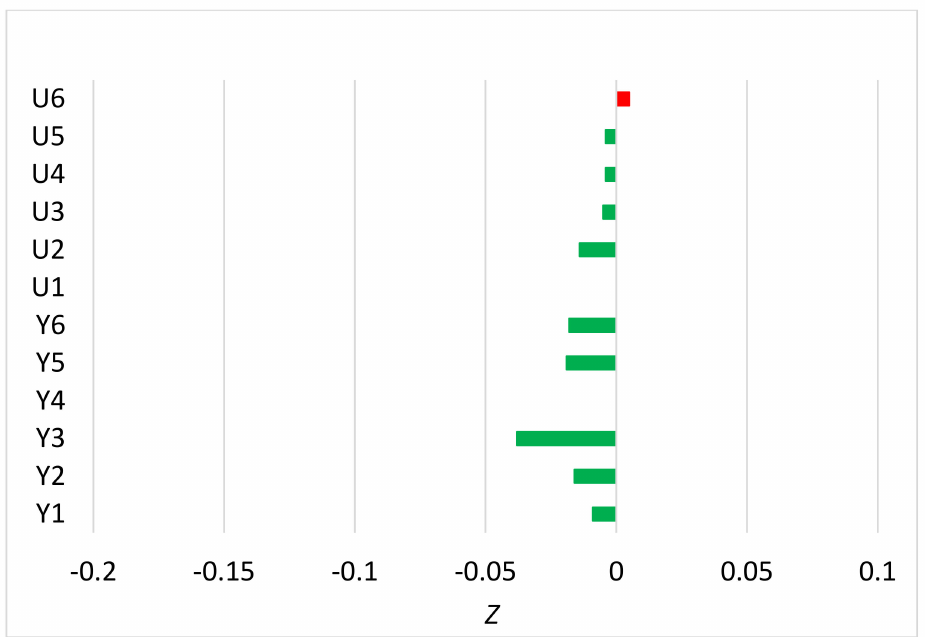
Figure 1. Mean normalized difference of monthly root mean squared errors (RMSEs) between ACMANTv5 and ACMANTv4. Negative values (green bars) mean improvement, positive values (red bar) mean worsening. Y (U) denotes synthetic (surrogated) test datasets.